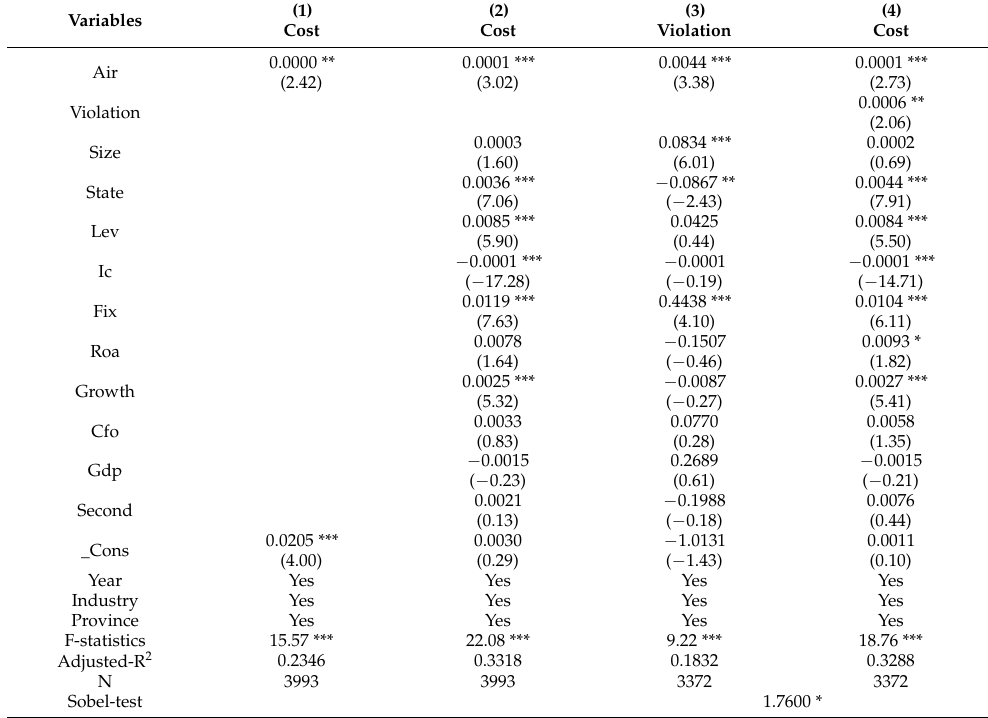
Table 6. Influence of air pollution on cost of debt and mechanism of environmental violation